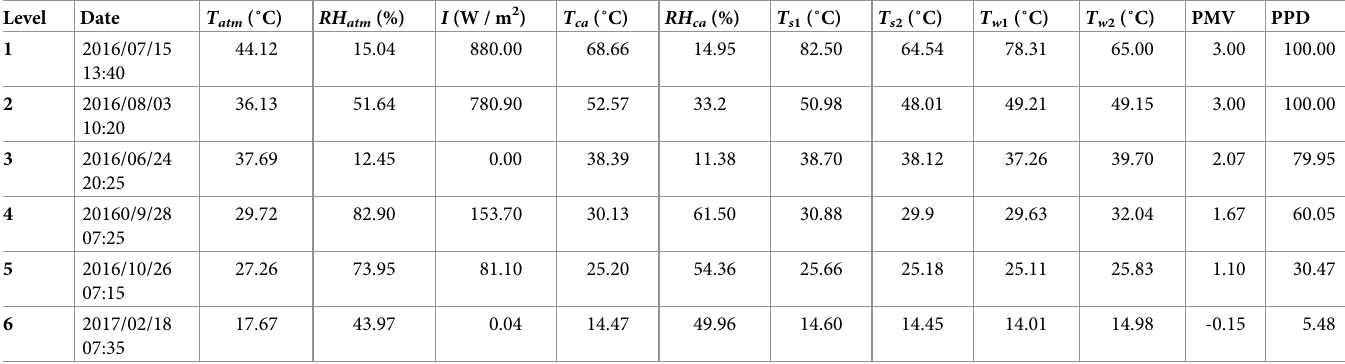
Table 1. The typical scenarios for different thermal environment levels.